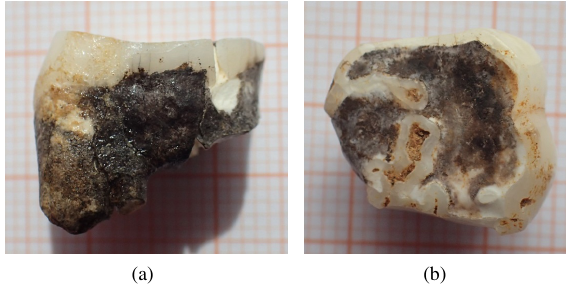
Figure 2. Studied samples of teeth from LangTrank: lt 8 view from distal surface (a) and lt 9 view from occlusal surface